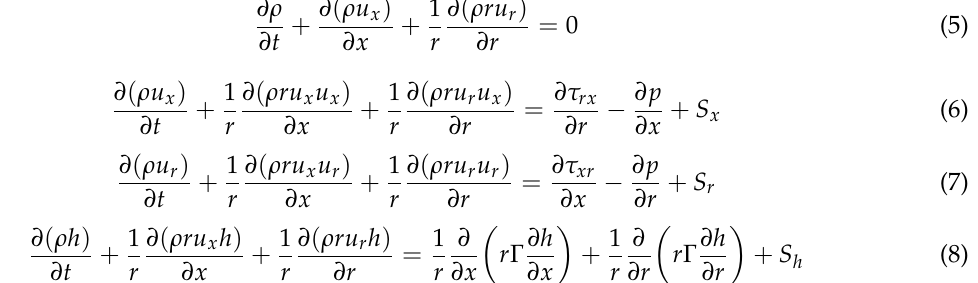
Figure 4. An example of six perforated plate configurations. Table 1. Geometric features of the plates resolved by CFD.